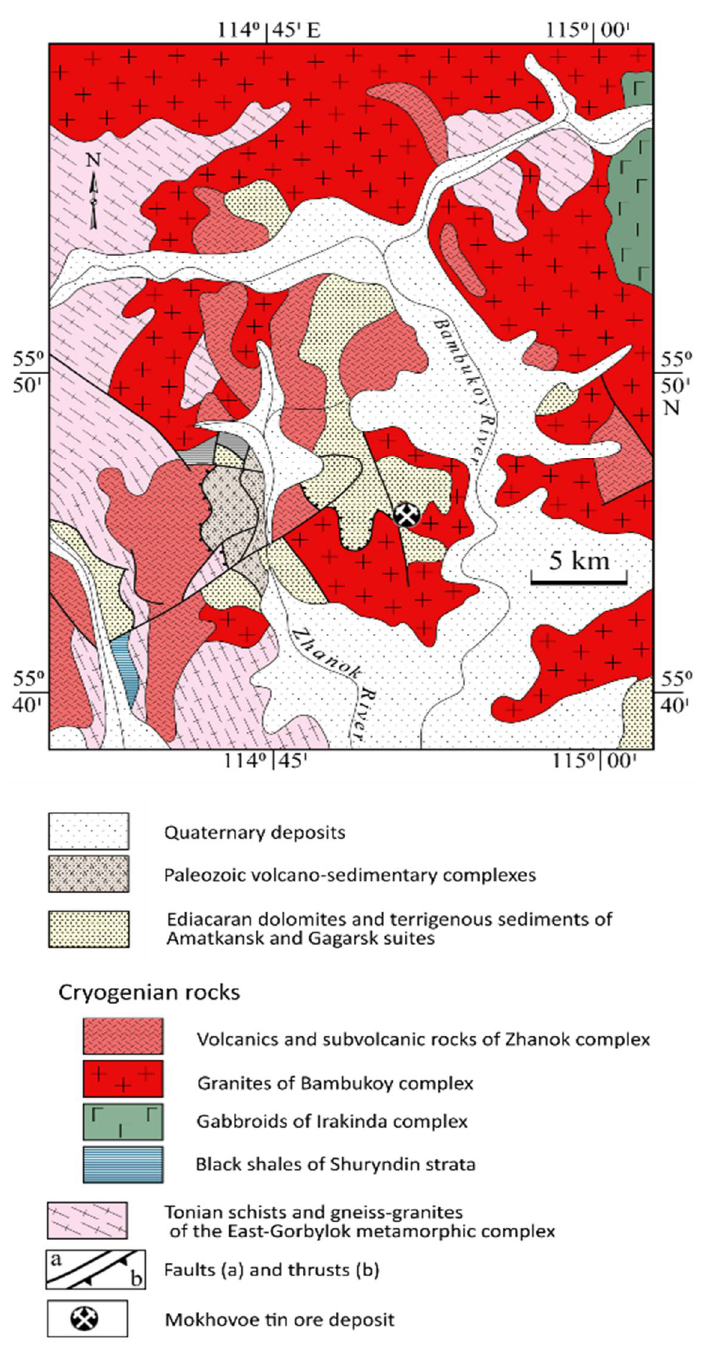
Figure 5. Simplified geologic map of the Mokhovoe tin deposit area, western Transbaikalia, East Siberia (modified from Kozlov et al. [61]).